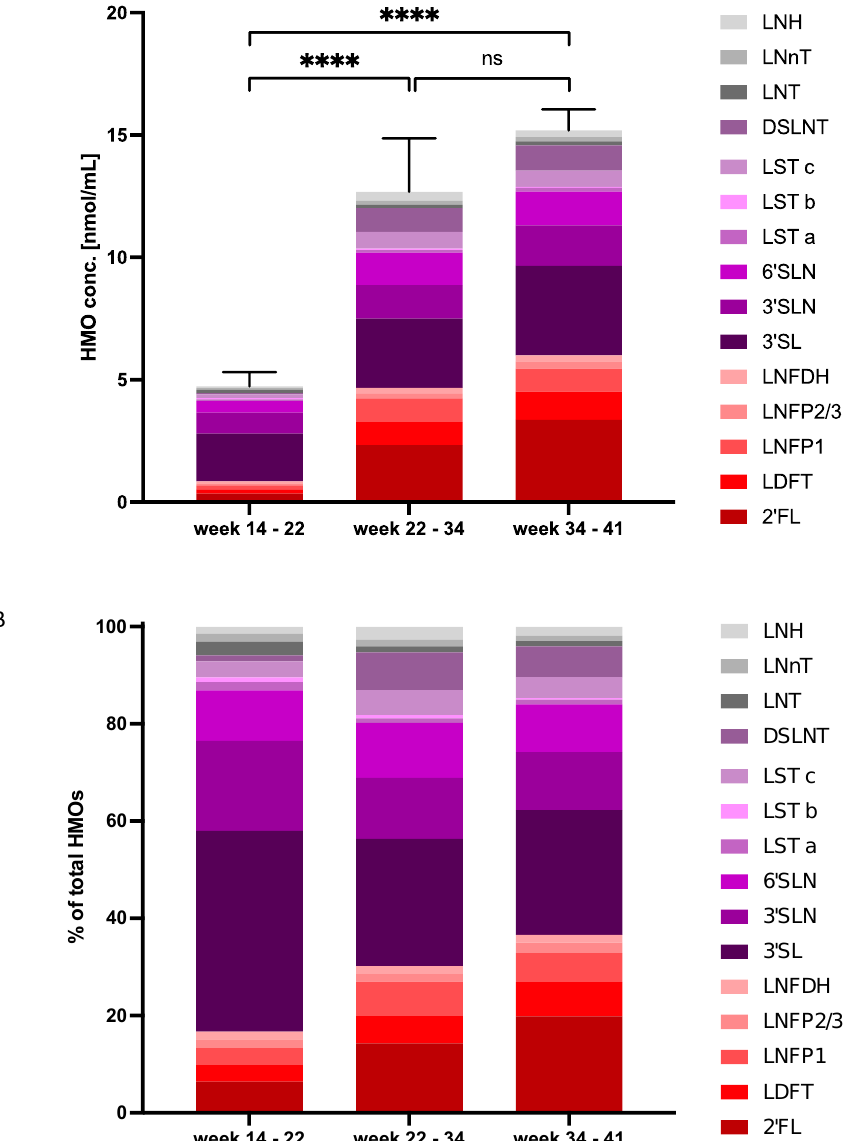
Figure 2. HMO concentrations and composition change with gestational age. AF samples from early (14.0 – 21.9 weeks, n = 8), mid- (22.0 – 33.9 weeks, n = 15) and late (34.0 – 41.0 weeks, n = 54) pregnancy were individually measured by HPLC. ( A ) Means ± SEM of total HMO concentrations (in nmol/mL) in the respective sampling periods were significantly different (Kruskal – -Wallis test with Dunn’s multiple comparisons test). Stacked bars show the means of unambiguously identified HMOs (without 3FL and 6SL/Hex4) for the three sampling periods. ns, not significant; **** p < 0.0001. ( B ) HMO composition changes with gestational age. Stacked bars show mean relative concentrations of unambiguously identified HMOs for the different sampling periods. Fucosylated HMOs ( 2′ FL, LDFT, LNFP1, LNFP2/3, LNDFH) are colored in shades of red, sialylated HMOs ( 3′ SL, 3SLN, 6′ SL, 6′ SL, LSTa, LSTb, LSTc, DSLNT) in shades of purple, and unmodified HMOs (LNT, LNnT, LNH) in shades of gray.